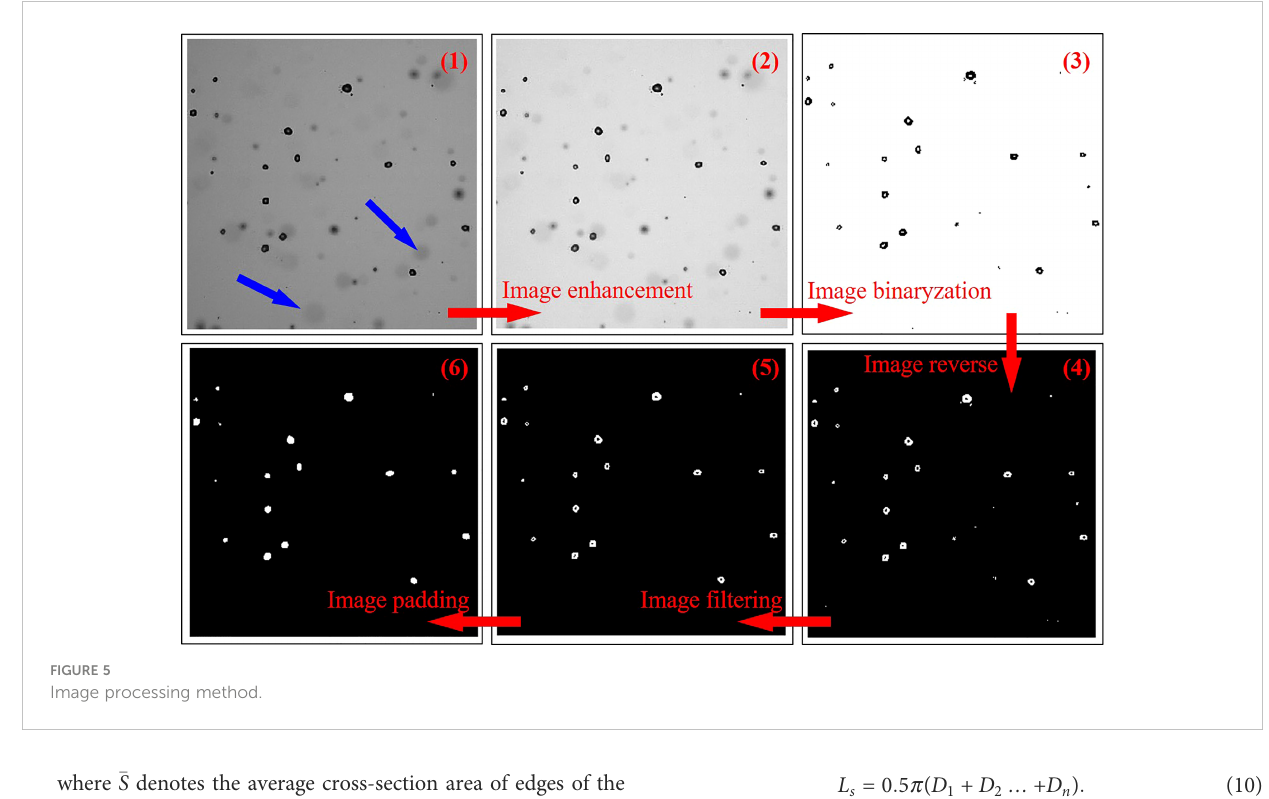
FIGURE 5 Image processing